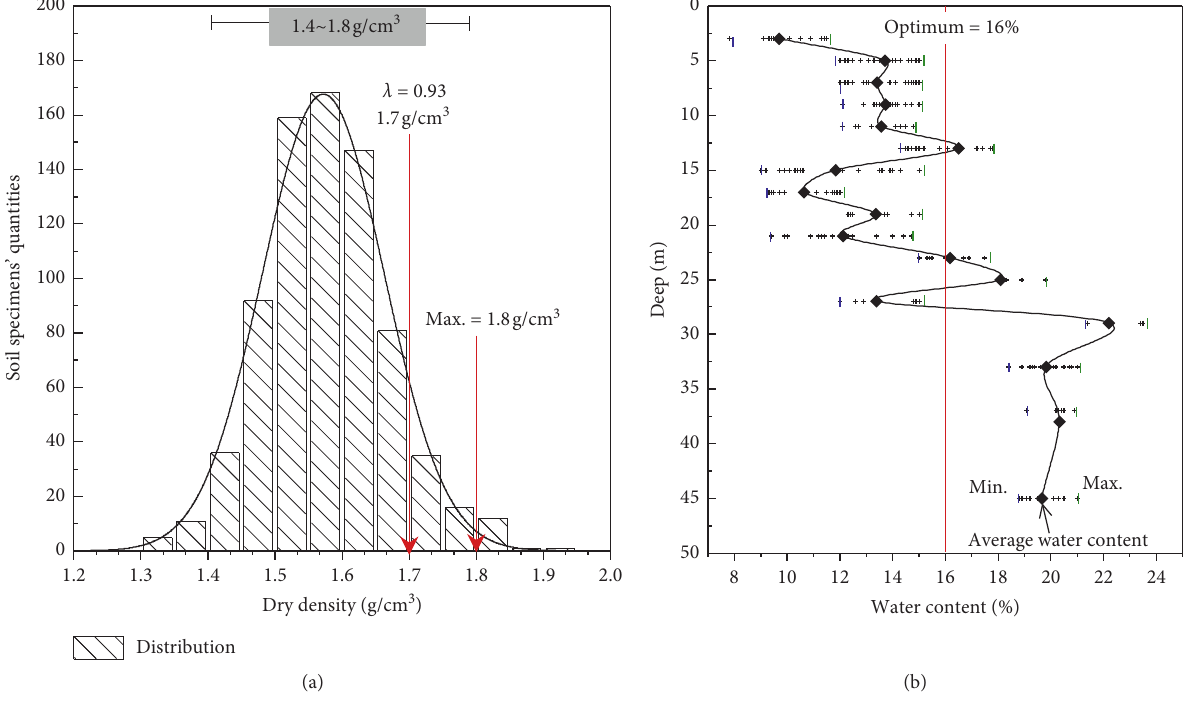
Figure 2: (a) Dry density and (b) water content in filled area. Table 1: Physical parameters of remolded specimens.